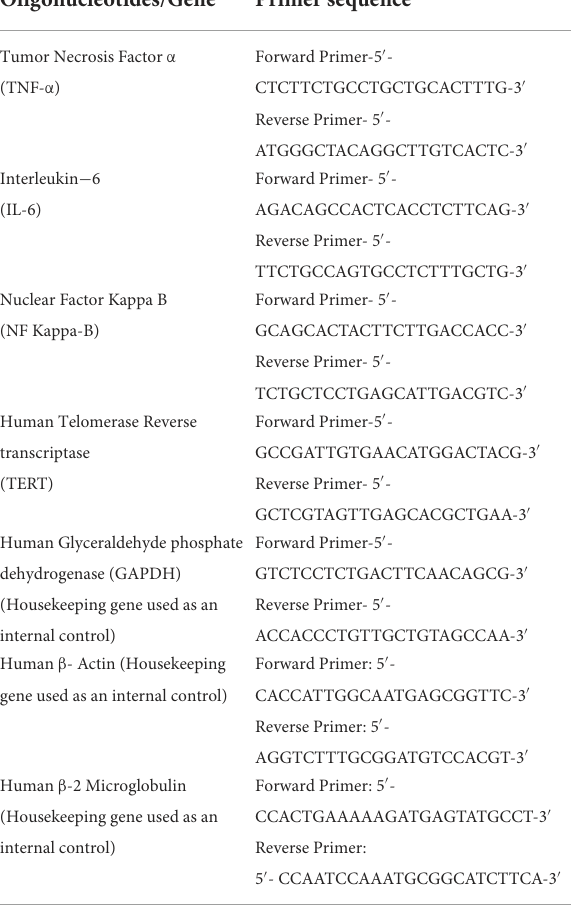
TABLE 3 List of oligonucleotides used in this study.